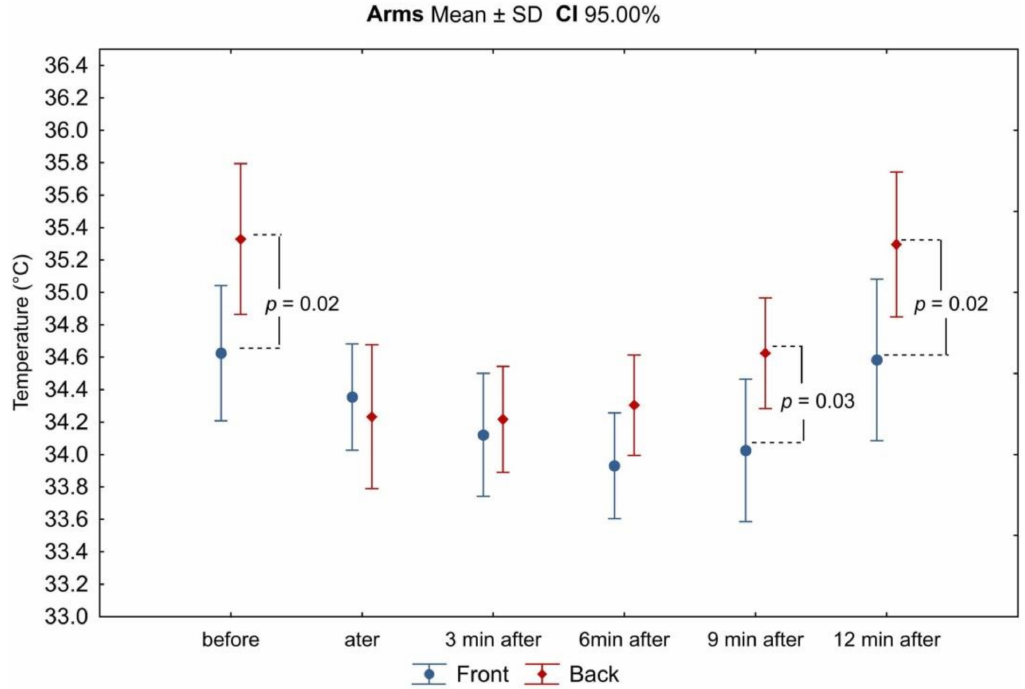
Figure 3. Differences in mean temperature values between the anterior and posterior surfaces of the arms during successive measurement points before and after the exercise test. Legend: the test probability level of the student t -test between the temperature of the anterior and posterior surfaces. Data are expressed as mean with standard